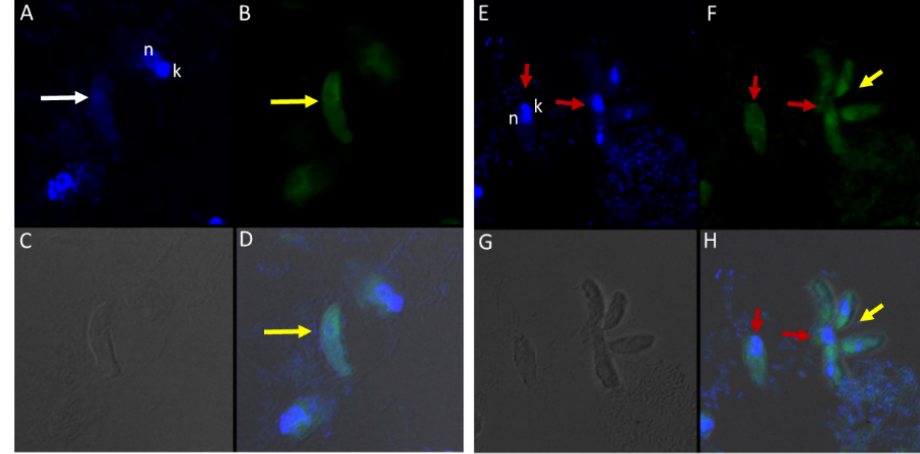
Figure 11. ( A – H ): Immunofluorescence microscopy of Colpodella sp. (ATCC 50594) trophozoites and cysts using anti-EBA175 antibodies. ( A , E ); DAPI stained nuclei of Colpodella sp. (ATCC 50594) (white arrow) and P. caudatus trophozoites (red arrow) showing nucleus (n) and kinetoplast (k). ( B , F ); anti-EBA175 reactivity with single Colpodella sp. trophozoite and multiple trophozoites feeding on a single P. caudatus . Yellow arrowhead shows cluster of four Colpodella sp. (ATCC 50594) trophozoites. ( C , G ); show DIC microscopy of Colpodella sp. (ATCC 50594) and P. caudatus trophozoites. ( D , H ); Merged image of anti-EBA175, DAPI and DIC. arrowhead, Figure 13A,B) from the prey was detected in the posterior food vacuole of a Colpodella sp. (ATCC 50594) trophozoite (yellow arrow) attached to P. caudatus prey (red arrow) (Figure 13A,E). The nucleus (n) and kinetoplast (k) of P. caudatus and the central nucleus of Colpodella sp. (ATCC 50594) trophozoite (white arrow) were identified by DAPI